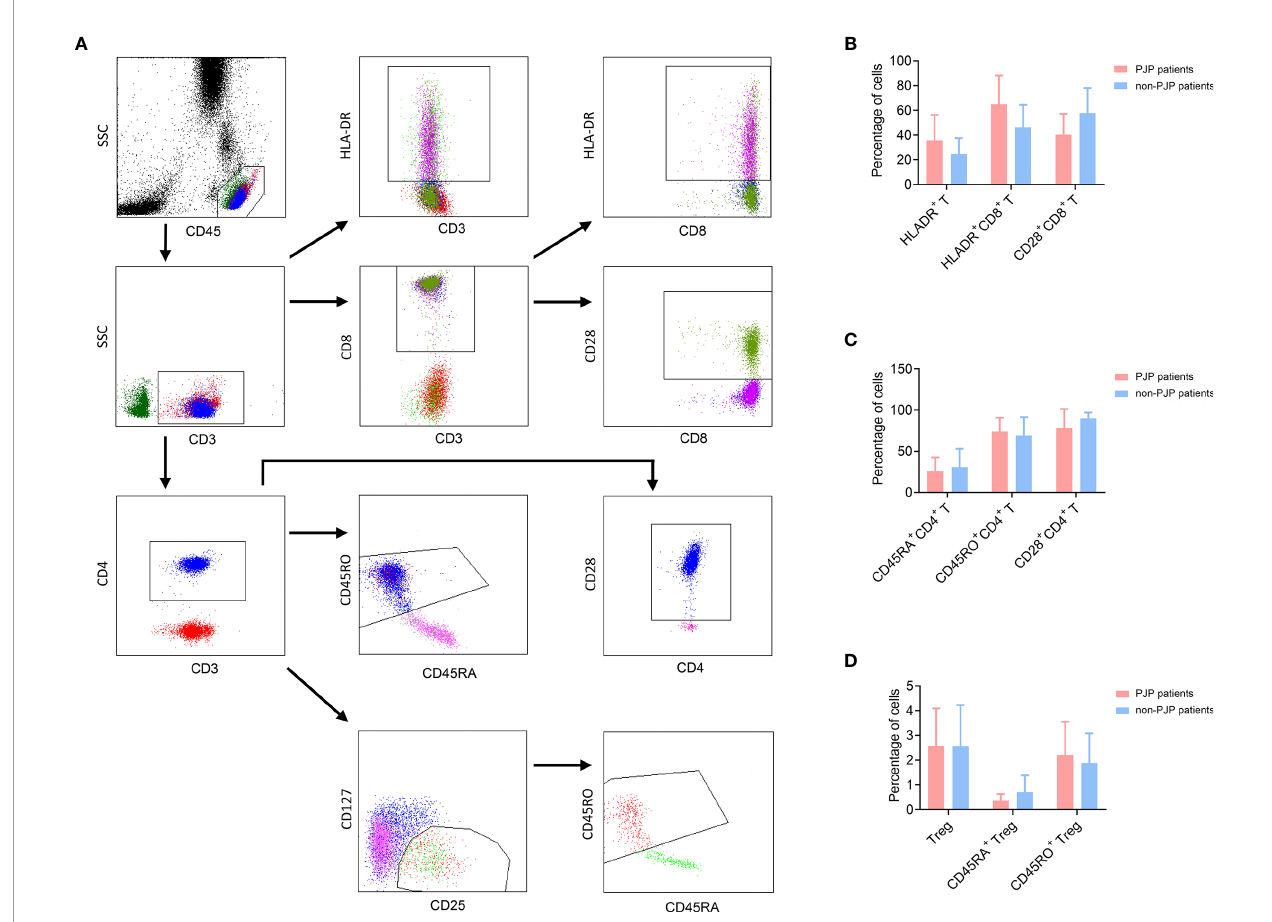
FIGURE 1 | Phenotype analysis of T cell subsets. (A) The gating strategies of phenotype analysis of T cell subsets. (B) The percentages of CD28 + CD8 + T cells, HLA-DR + CD3 + T cells, HLA-DR+CD8+ T cells in PJP and non-PJP patients are shown in histogram. Data are expressed as mean ± SD. (C) The percentages of CD28 + CD4 + T cells, CD45RA + CD4 + T cells, CD45RO + CD4 + T cells in PJP and non-PJP patients are shown in histogram. Data are expressed as mean ± SD. (D) The percentages of CD4 + CD25 + CD127 - Treg cells, CD45RA + Treg cells and CD45RO + Treg cells in PJP and non-PJP patients are shown in histogram. Data are expressed as mean ± SD.